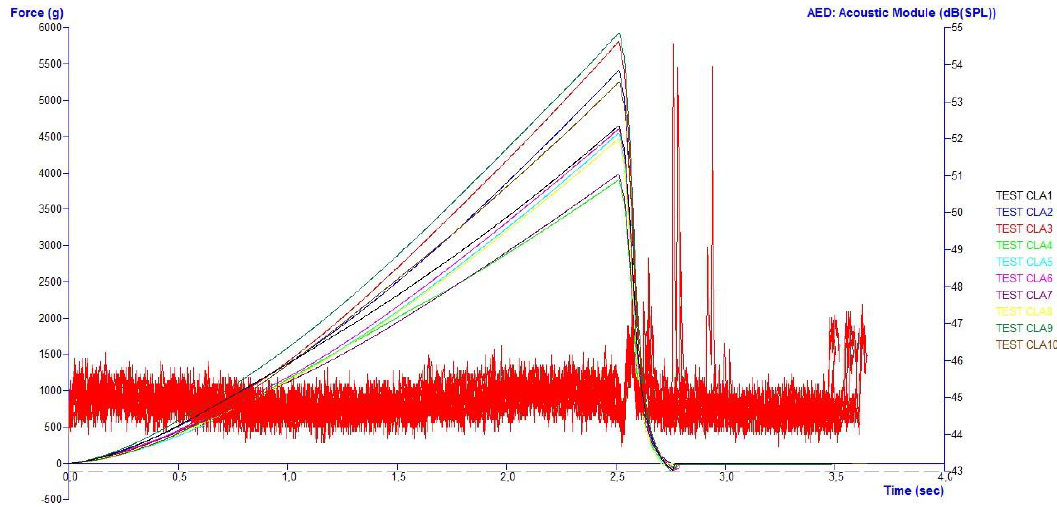
Figure 2. A representative compression/acoustic plot.